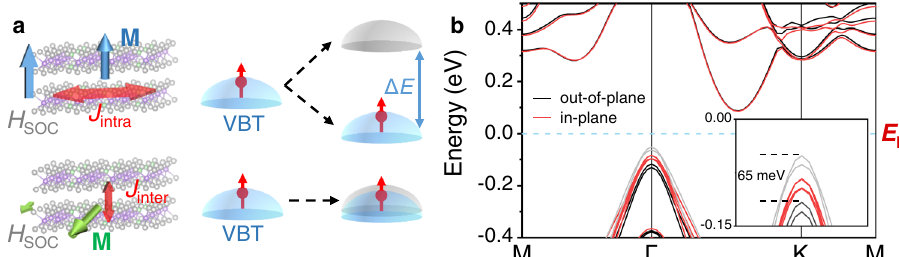
Fig. 1 | Van der Waals lattice-induced magneto band-structure effect in CGT. a Schematic of the band splitting induced by the interaction between the aniso- tropic crystalline fi led and the magnetization. The top of valance bands (VBT) occupied by spin majority and minority are colored in blue and grey, respectively. b Calculated band structures of CGT bilayer with the in-plane and out-of-plane